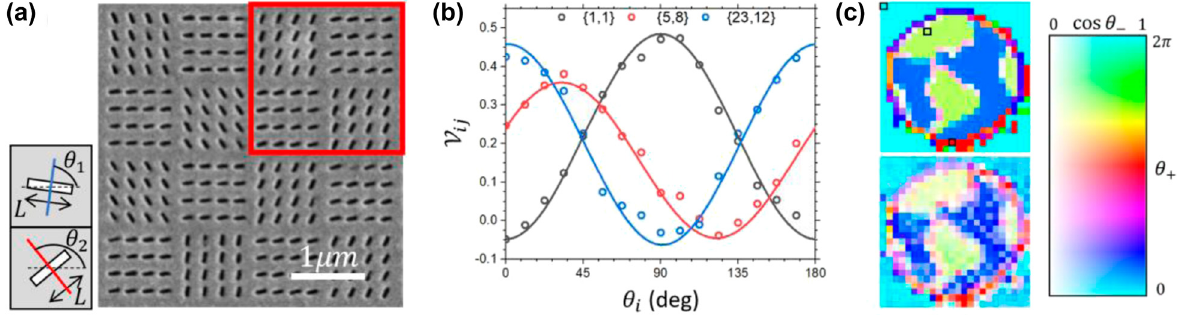
Figure 4: 2 degrees of freedom coincidence imaging. (a) Zoom-in SEM image of the fabricated sample. Each pixel in Figure 3(a) (red square) is divided into a checkerboard format with a neighboring sub-pixel consisting of nano-slots with the same length but different slot and 𝜃 ) as indicated by the insets. The red and blue lines represent the slot’s passing axes of the nano-slots. (b) The orientations ( 𝜃 ( ) 1 2  measured visibility for three example pixels (indicated in (c) by open squares) of the object. The as a function of the reference angle 𝜃 ij i solid curves are fit using the visibility model. (c) The target image (upper figure) and the retrieved image (lower figure). For better comparison, the images are colored by mapping the values of 𝜃 + and cos 𝜃 − to the hue and saturation, respectively, of the HSB color scale for unitary brightness. Note that the dead pixels are smoothed out similar to Figure